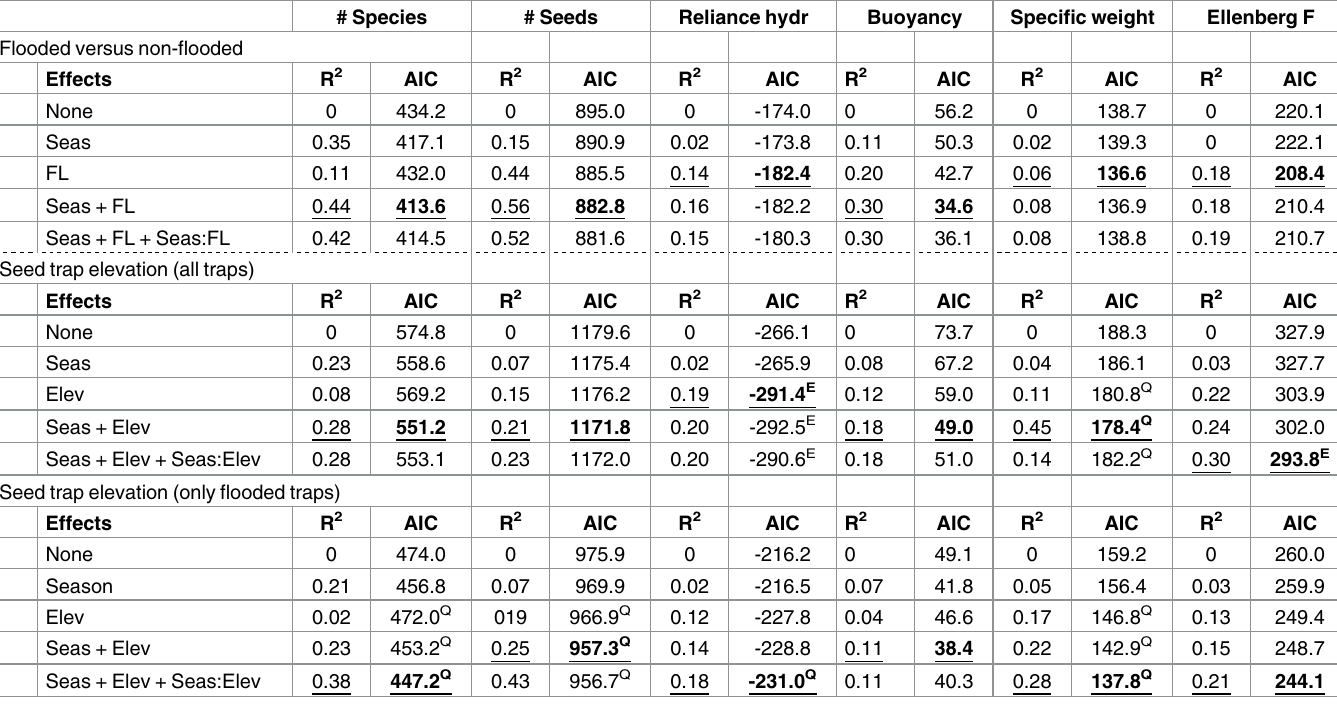
Table 2. Forward selections of fixed effectsin (negative binomial G)LMMs explaining species number and number of seeds in the seed